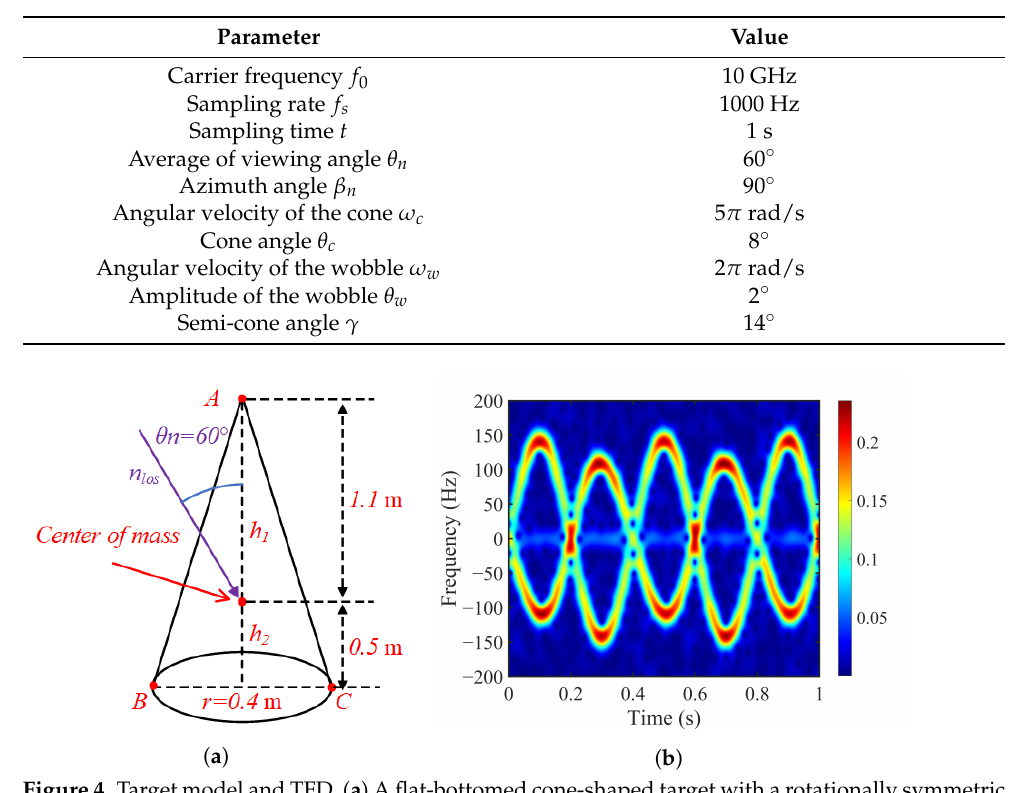
Table 2. Simulation parameter settings.